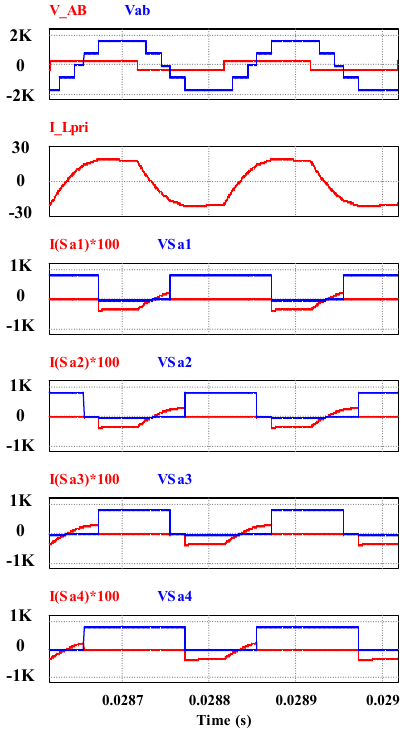
Figure 13. Voltage across the transformer (cid:1874) currents and voltages for (cid:1845)